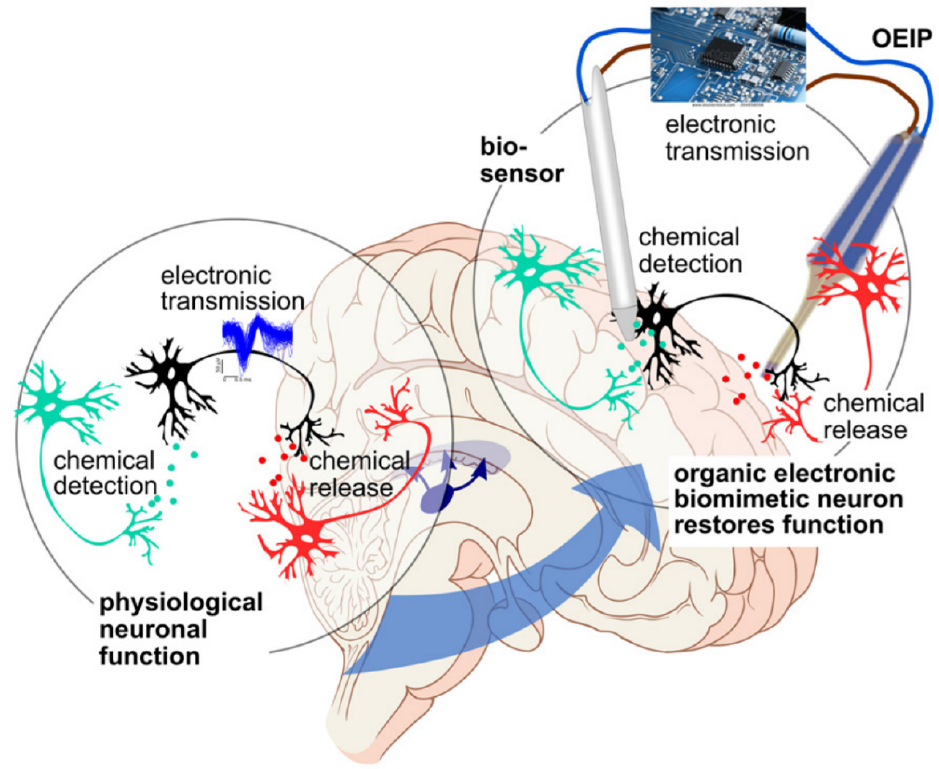
Figure 1. Schematic depicting the merging of biotechnology, electronics and materials science [6].